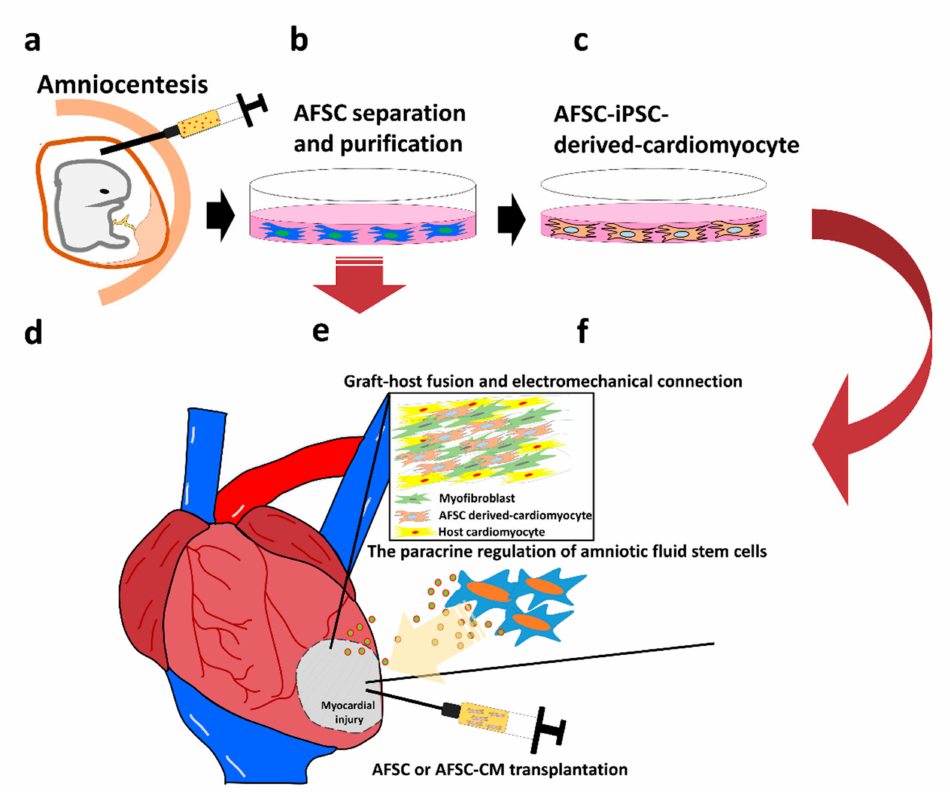
Figure 1. The mechanism of myocardial regeneration by using amniotic fluid stem cells. a. Amniotic fluid was taken out during pregnancy by amniocentesis and amniotic fluid stem cells were isolated and purified. b. After specific screening, amniotic fluid stem cells were amplified in vitro for use directly or c. induced into cardiomyocyte through in vitro well established differentiation procedures. d. Via intramyocardial injection to transplants amniotic fluid stem cells or amniotic fluid stem cells derived cardiomyocytes into ischemic necrotic myocardial tissue. The injuried myocardium were repaired by e. graft fusion with host myocardium, and act coupling contraction and current conduction. f. Amniotic fluid stem cells may also protection cardiomyocytes through paracrine by release growth factors into myocardial